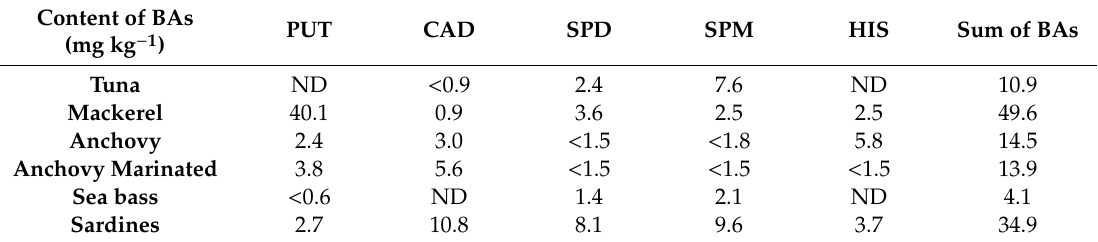
Table 8. Biogenic amines’ concentrations (mg kg − 1 ) in canned fish